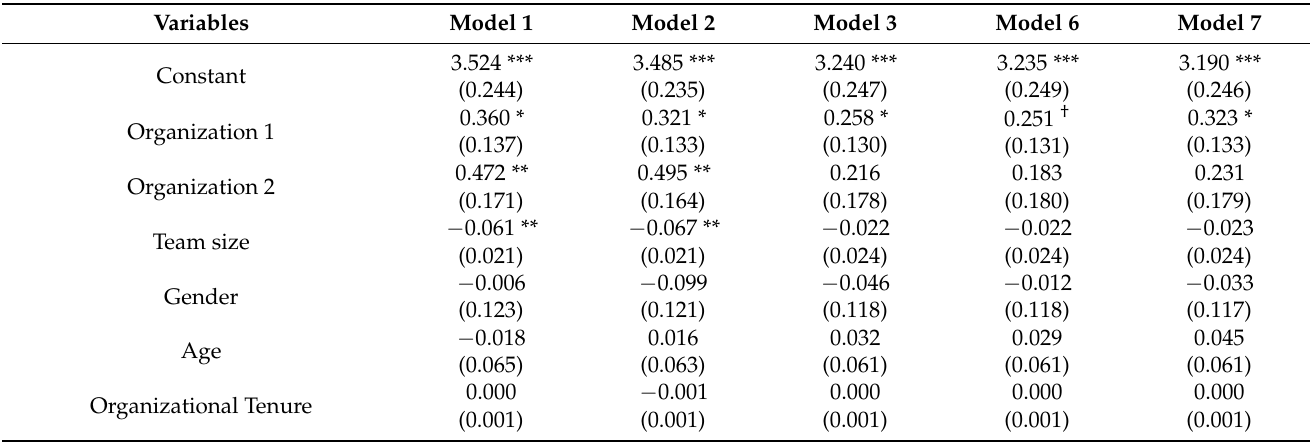
Table 5. Results of Regression Analyses for Prohibitive Voice and Individual